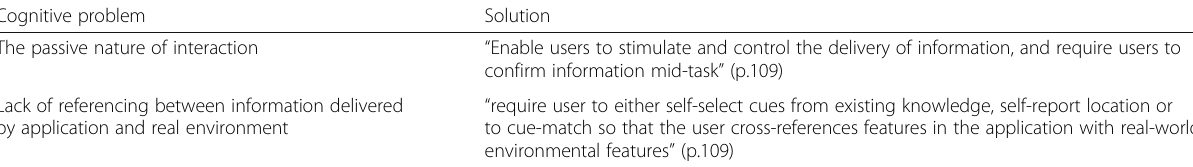
Table 1 Two cognitive problems and their suggested solution based on Willis et al. (2009) Cognitive problem Solution The passive nature of interaction Lack of referencing between information delivered by application and real